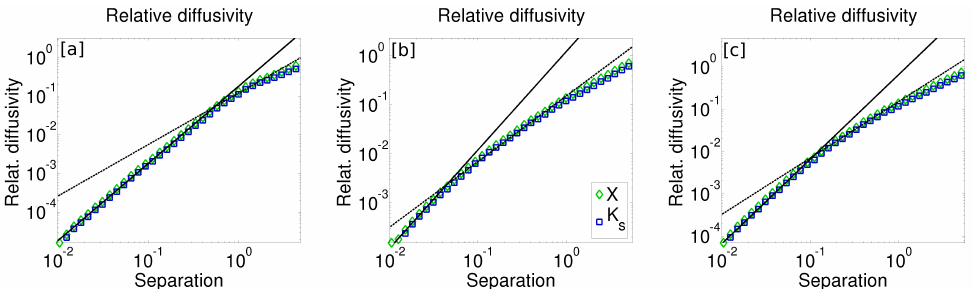
Figure 4. Comparison between the instantaneous dispersion coefficient X (green diamonds), and the scale-averaged positive relative diffusivity K s (blue squares). The solid black line represents a r 2 slope and the dashed grey line a r 4/3 slope. Panels ( a – c ) show the results for the model runs A, B, and C, respectively.